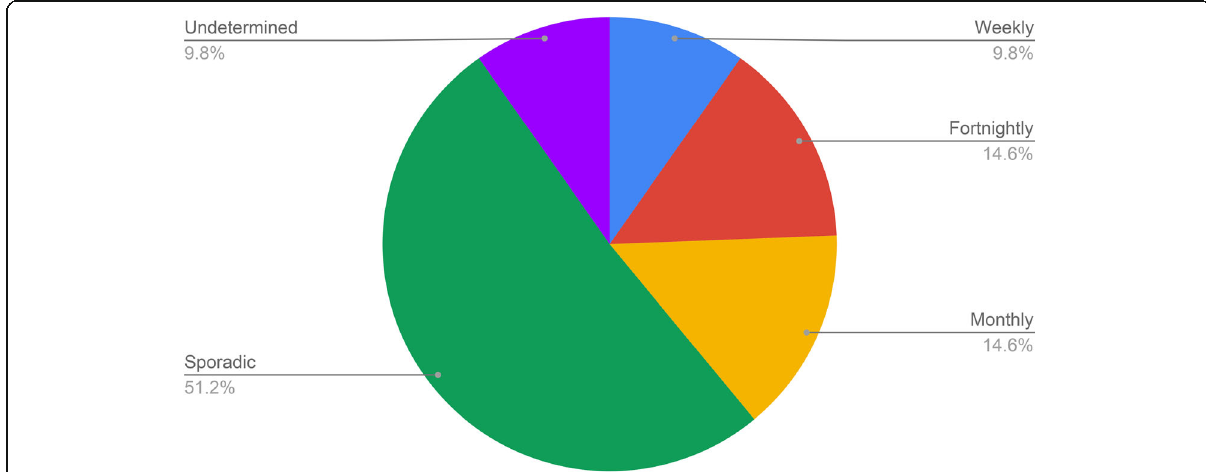
Fig. 3 Podcast series ’ frequency/schedule. The pie chart shows the distribution of scheduling of new podcast episodes for each podcast series. The largest proportion sampled were sporadic (51.2%), followed by monthly and fortnightly (both 14.6%), then weekly and undetermined (both